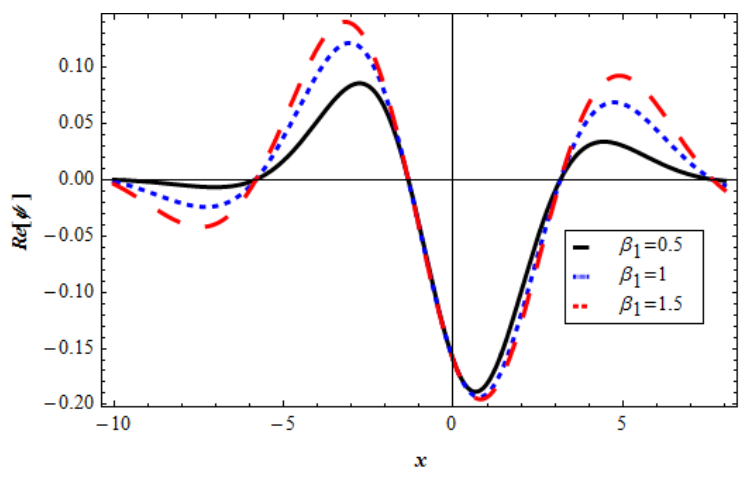
Figure 11. Change of solution (19) with z , t , β 1 for c = 0.5, v = 0.7, β 2 = 0.1, β 3 = 0, β 4 = 0.